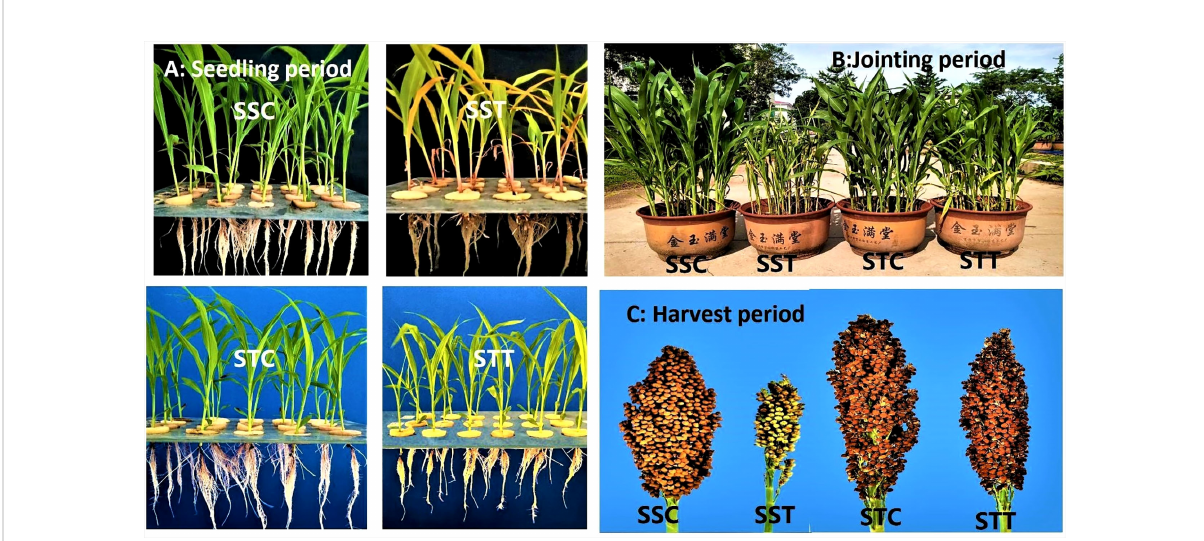
FIGURE 1 Phenotypic differences between salt-tolerant and salt-sensitive genotypes of sorghum under control and salt stress at seedling period, jointing period, and mature period (A) Control vs salt stress phenotypic differences at seedling period. (B) Control vs salt stress phenotypic differences at jointing period. (C) Control vs salt stress phenotypic differences at harvest